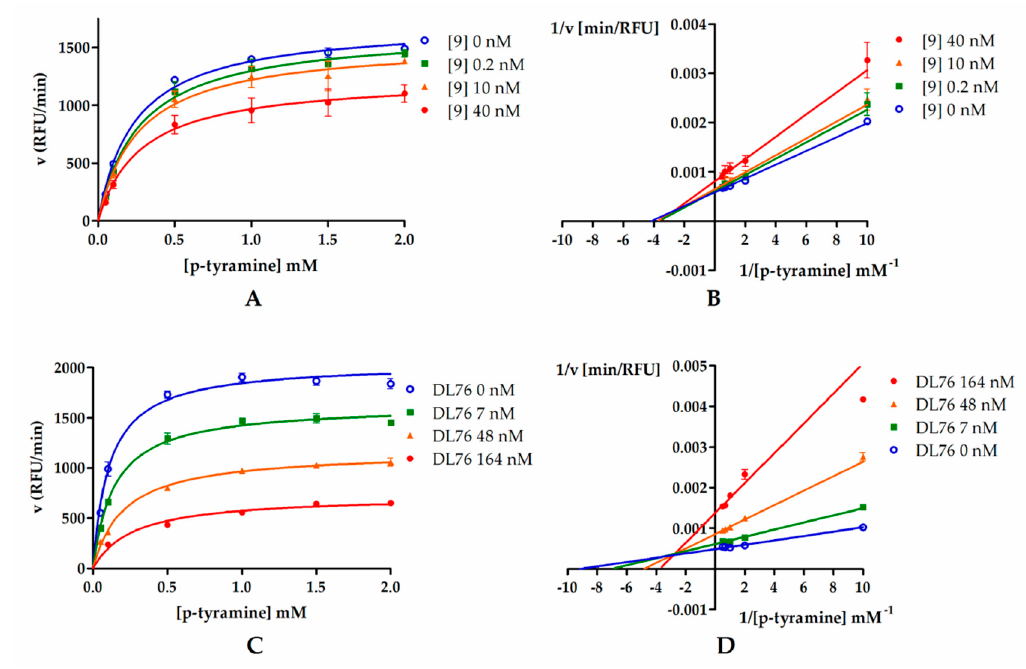
Figure 4. Michaelis–Menten curves for compound 9 ( A ) and DL76 ( C ): Inhibitors were tested in three concentrations (0.2 nM, 10 nM, and 40 nM for 9 and 7 nM, 48 nM, and 164 nM for DL76 ) representing their IC 20 , IC 50 , and IC 80 , respectively. Substrate (p-tyramine) was used in six concentrations: 0.05 mM, 0.1 mM, 0.5 mM, 1 mM, 1.5 mM, and 2 mM. ( B , D ) Double-reciprocal (Lineweaver–Burk) plots from enzyme kinetic studies. Table 2. V max and K m calculated from Michaelis–Menten curves of compound 9 and DL76 .